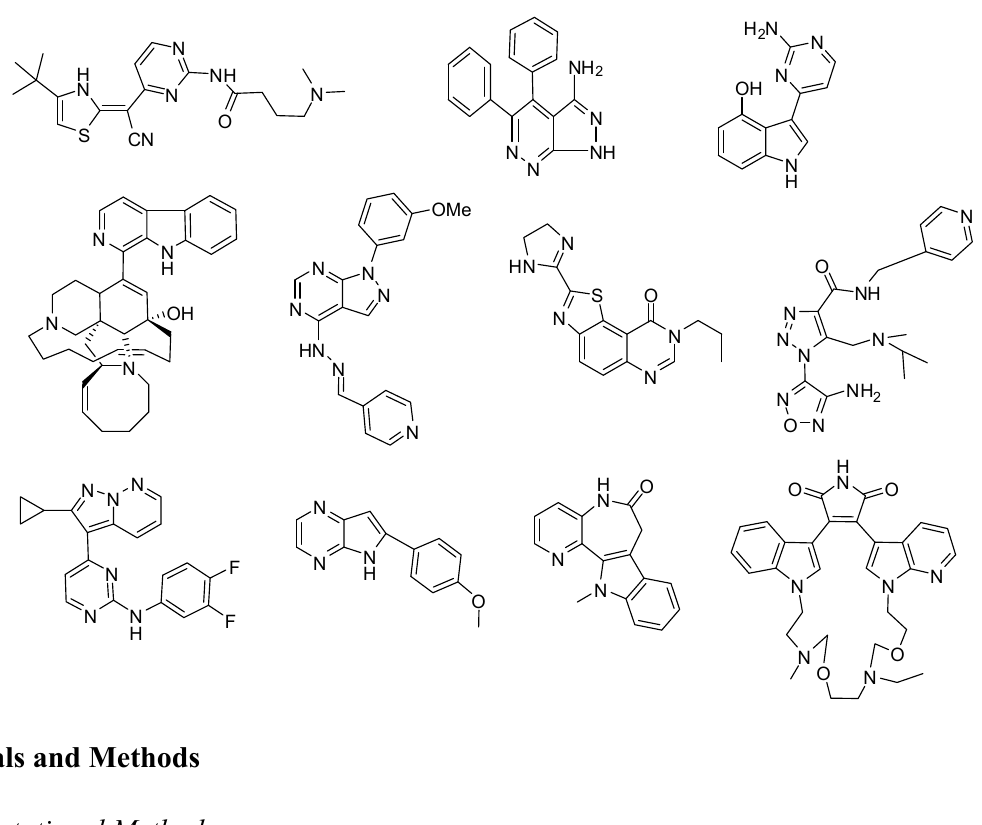
Figure 1. Some compounds studied in this article.